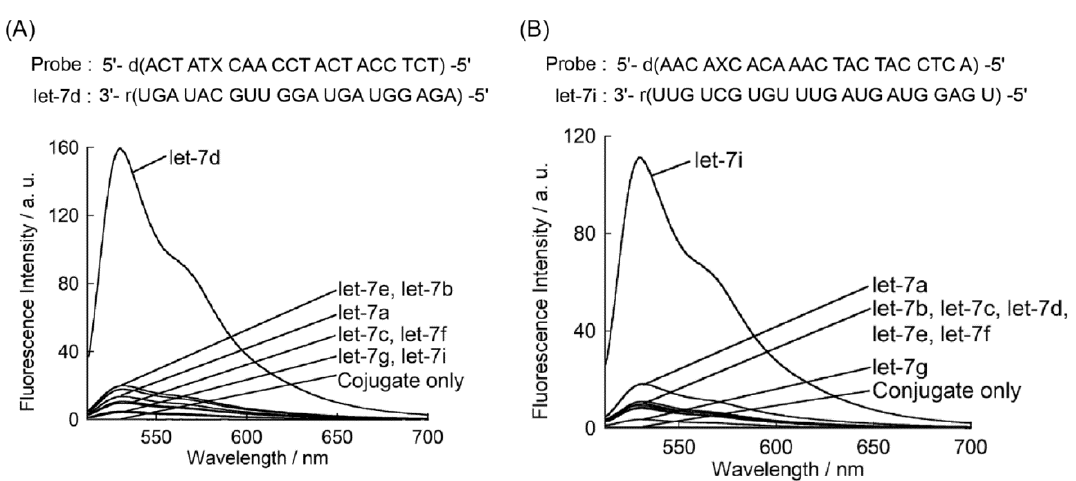
Figure 5. Selective detection of ( A ) let-7d and ( B ) let-7i sequences by ClNaph–TO conjugate in